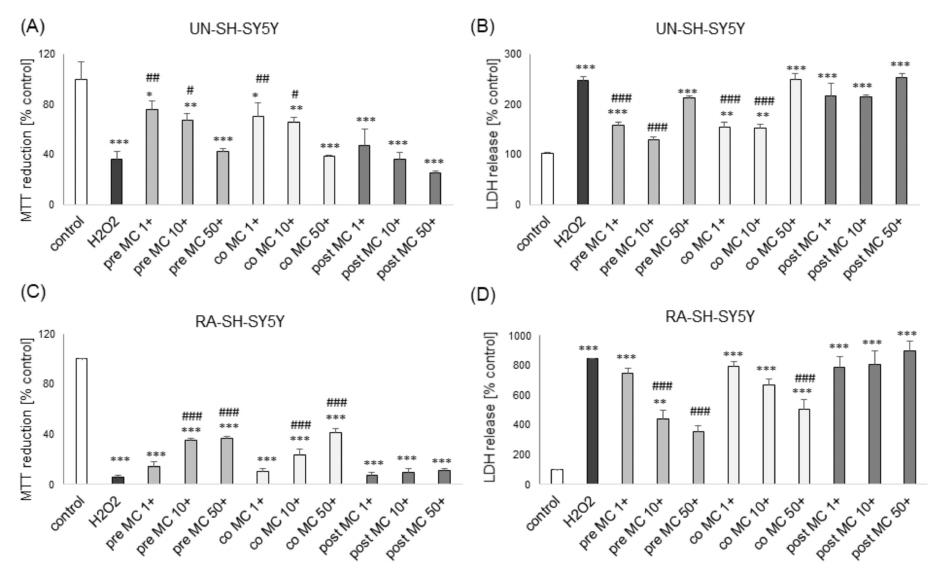
Figure 5. The protective effects of MC against hydrogen peroxide (H 2 O 2 )-evoked UN- or RA-SH-SY5Y cell damage are retained under pre- and co-treatment but not in post-treatment conditions. ( A , C ) Cell viability of UN-(A) and RA-(C) SH-SY5Y cells pre-treated (30 min. before H 2 O 2 ), co-treated and (30 min. after H 2 O 2 ) with MC (1–50 µ M) followed by 24 of treatment with H 2 O 2 (0.25 and 0.5 mM for UN- and RA-SH-SY5Y cells, respectively) as measured by MTT reduction assay. ( B , D ) Cell toxicity in